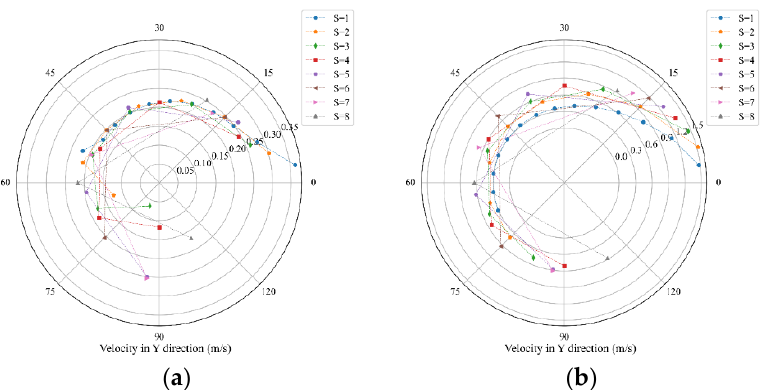
Figure 20. Particle velocity in the y-direction. ( a ) Flat surface; ( b ) Convex pattern surface.